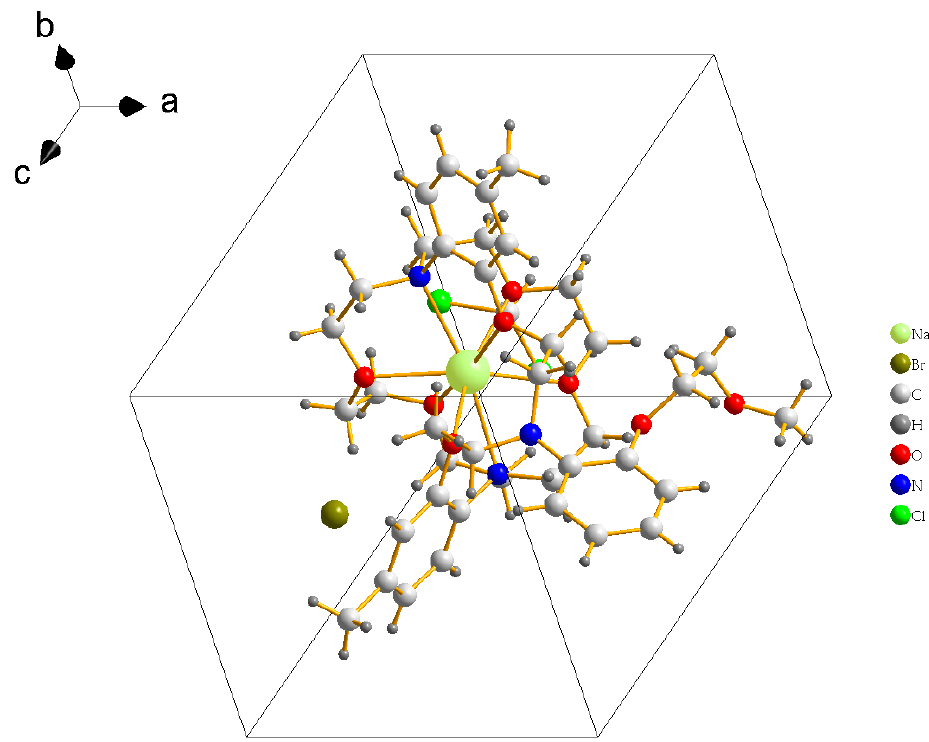
Figure 1. Crystal structure of 2 , the title compound.